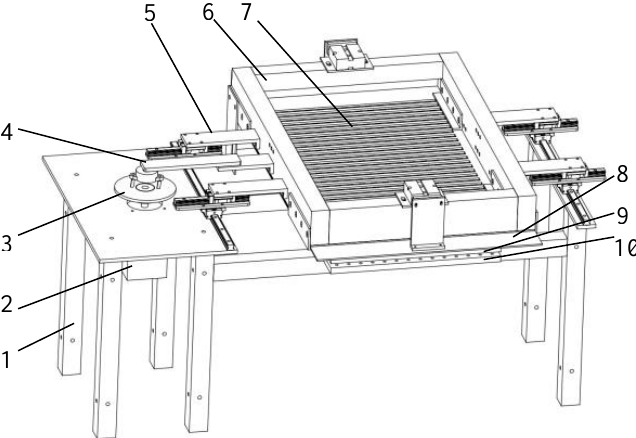
Figure 2. Structure of horizontal rotary precision seed metering device. 1. Frame; 2. Motor; 3. Eccentric disc; 4. Connecting plate; 5. Support plate; 6. Seed filling box; 7. Upper plate; 8. Lower plate; 9. Seed guiding device; 10. Tray.